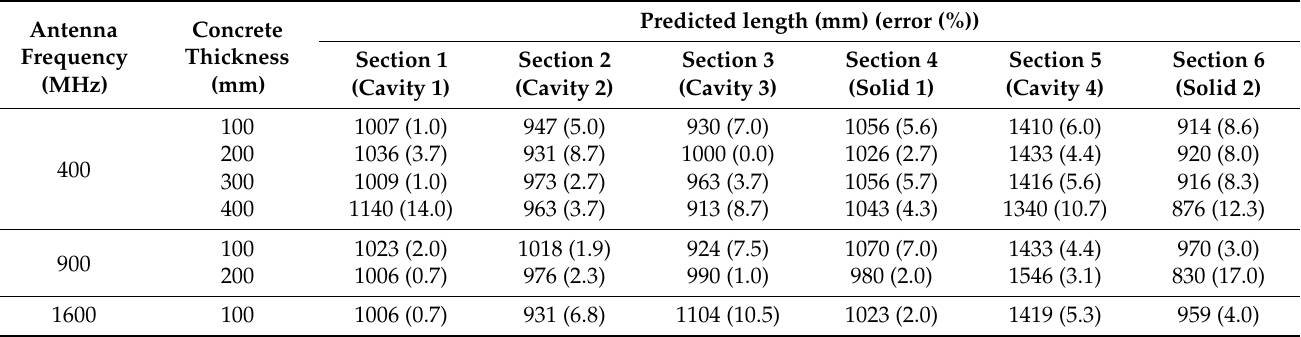
Table 4. Summary of predicted length of solid section and air-cavities behind concrete based on the spatial variation of cross-correlation coefficient of GPR